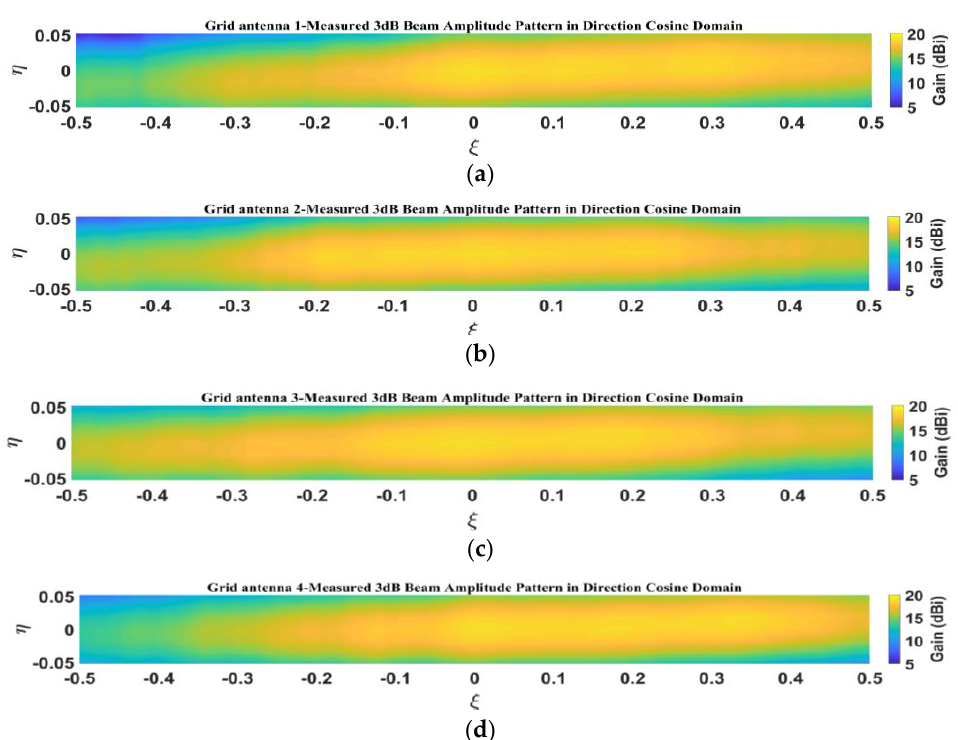
Figure 20. Measured amplitude pattern of 3-dB beamwidth in direction cosine domain: ( a ) grid antenna 1; ( b ) grid antenna 2; ( c ) grid antenna 3; ( d ) grid antenna 4. Figure 21a,b shows the measured co-polarization and cross-polarization patterns of every antenna element for the E and H planes in the 1D sparse array, respectively. A sum- mary of the measured results is given in Table 5.